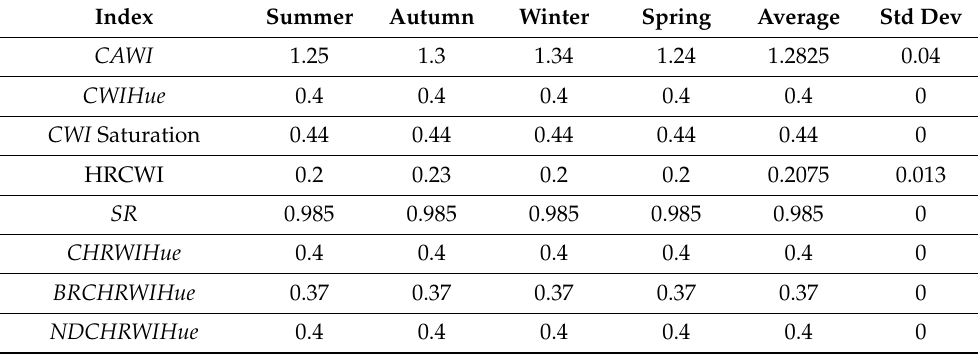
Table 5. Thresholds for best performing indices, with standard deviations as an indication of threshold stability. All indices calculated from image reflectance values divided by